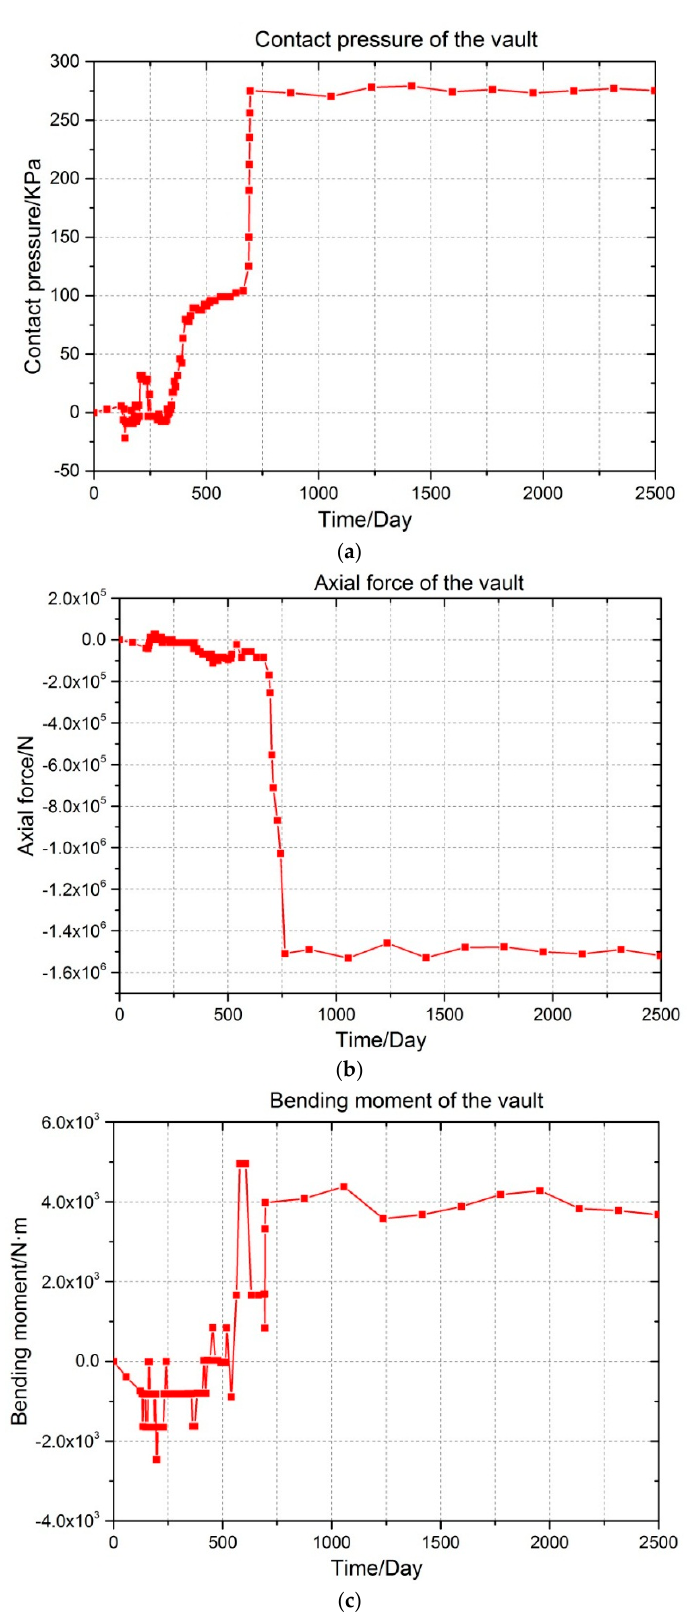
Figure 10. Time-history curve of the contact pressure, axial force, and bending moment of the vault (K102+340 section). ( a ) Contact pressure; ( b ) Axial force; ( c ) Bending moment.